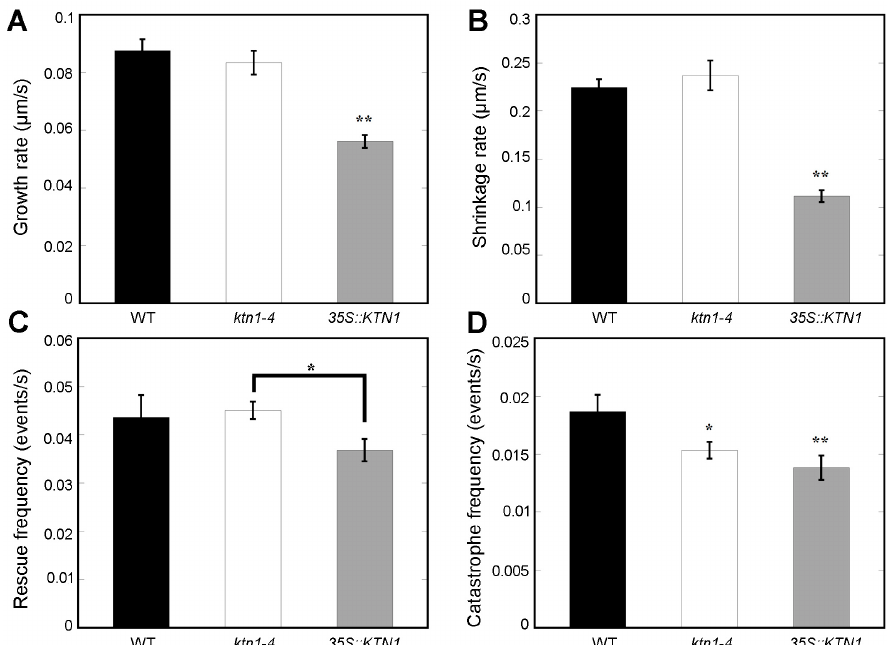
indicate the severing events. Different colors (red, blue, green and yellow) indicated different filaments. See Supplemental Movie 1-3 online for the entire series. Scale bar = 5 μ m. ( B ) Quantitative comparison of severing frequencies in microtubules of WT (Col-0), ktn1-4 and 35S::KTN1 cells (n = 6 cells for each genotype). Error bars indicate SE. ** P < 0.01 by a Student’s t test. ( C ) Quantification of the proportions of severing events (severed at branched sites, microtubule crossovers or at free